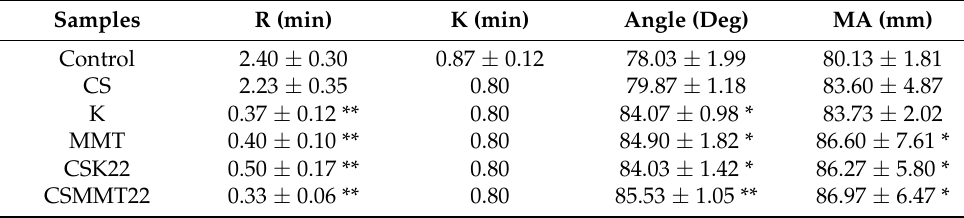
Table 2. In vitro TEG results. Data represent the mean ± SD ( n = 3). * p < 0.05; ** p < 0.01 compared to